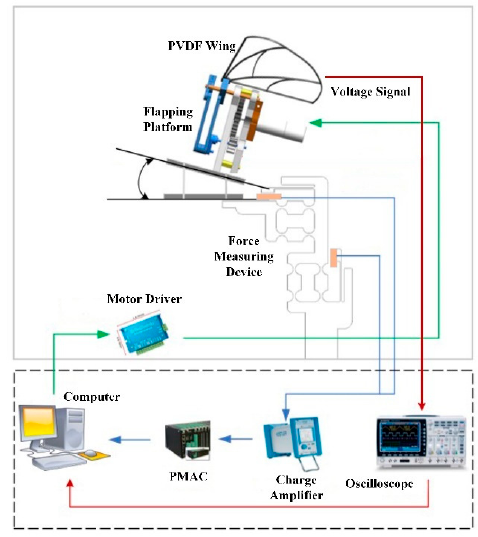
Figure 5. The test system composition.